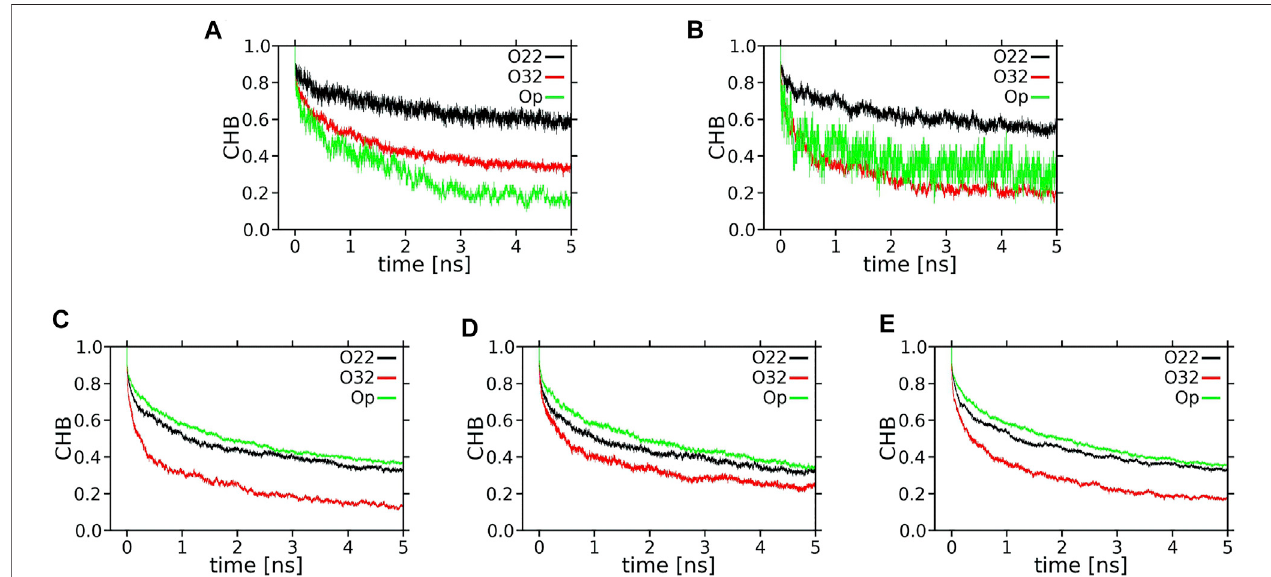
FIGURE 11 | Time pro fi les (decay curves) of the number of H-bonds between XAN-OH and POPC oxygen atoms (CHB) during the lag time of 5 ns. (A) ε -ring, (B) ß -ring, of the horizontal lutein, (C) ε -ring, (D) ß -ring, of a vertical lutein, (E) ß -ring of zeaxanthin (vertical orientation).